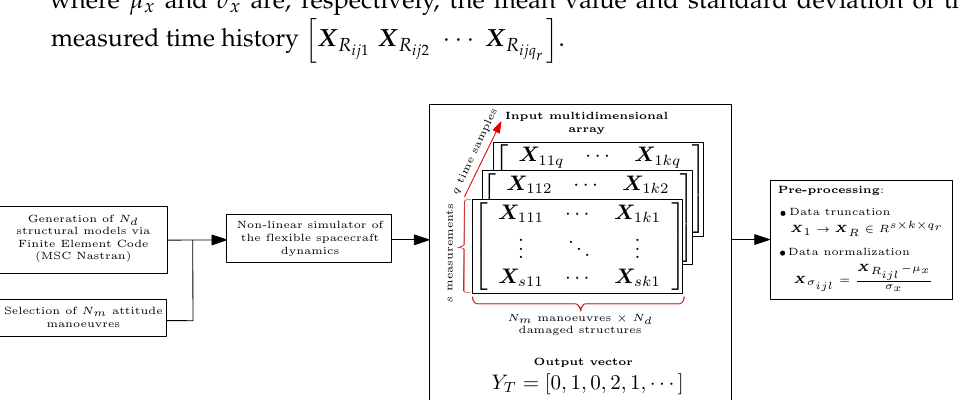
Figure 5. Dataset generation and processing prior to network training.